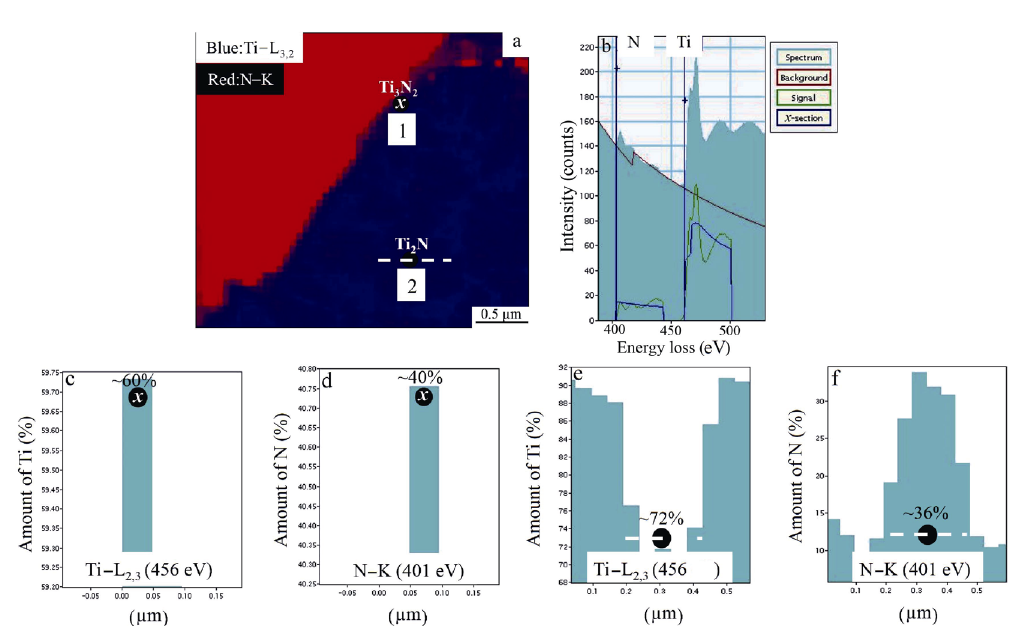
Fig. 7 (a) STEM − SI spectrum image, (b) STEM − SI − EELS quantitative elemental line scan spectrum obtained by N–K and Ti–L 2,3 edges along the dashed white line, (c, d) atomic quantity of Ti and N from point 1 corresponding to Ti 3 N 2 phase (marked with black), and (e, f) atomic quantity of Ti and N from point 2 along to dashed line corresponding to Ti 2 N phase (marked with